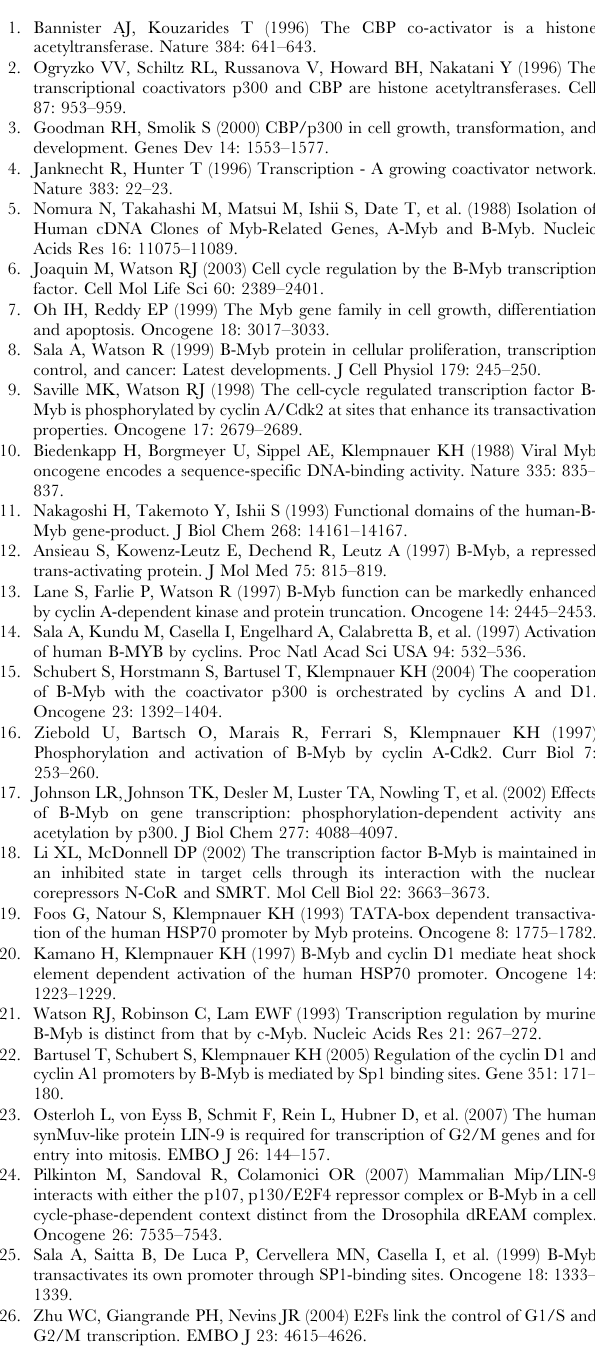
Figure S3 Comparison of the B-Myb TAD and the DNA bound MEF2 binding sites on p300 TAZ2. Panel A shows a contact surface view of CBP TAZ2 (left) with the location of the B- Myb TAD binding site on p300 TAZ2 highlighted as described in figure 5. For comparison, the structure of p300 TAZ2 bound to three MEF2 dimers (right; PDB code; 3P57, residues 1–95 [68]) are shown in the same orientation, with the TAZ2 domain shown as a contact surface and the three MEF2 dimers as ribbon representations of their backbone conformations. For clarity the DNA fragments, which bind to opposite face of the MEF2 dimers have been omitted from the figure. The views in panels B and C